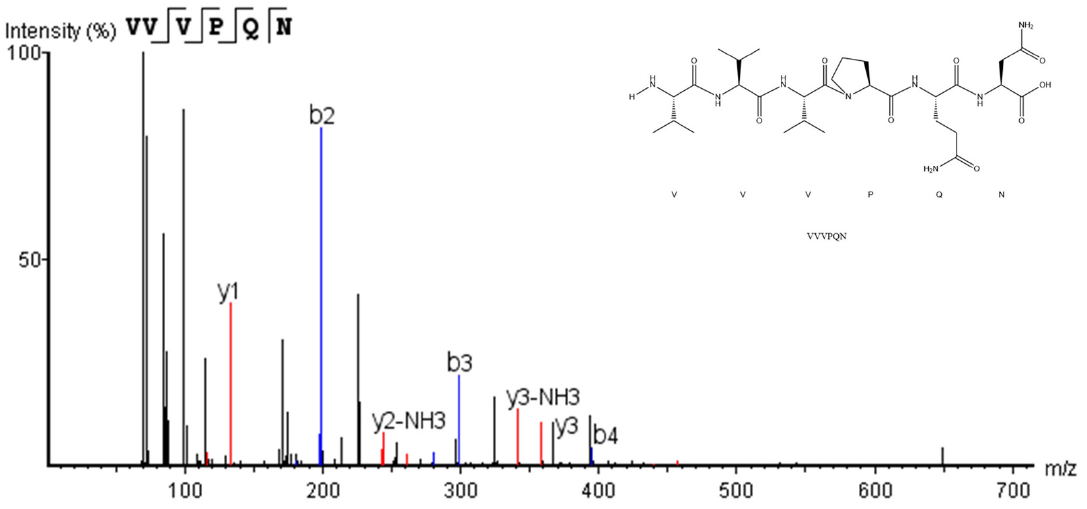
Figure 4. (a) The number of peptides with varying lengths identified from the F2 component. (b) The selected peptides’ ACE inhibitory activity. (c) The ACE inhibitory activity and the regression analysis of VVVPQN. The results are presented as the means ± SD (n = 3). Different letters indicate significant differences at p < 0.05.